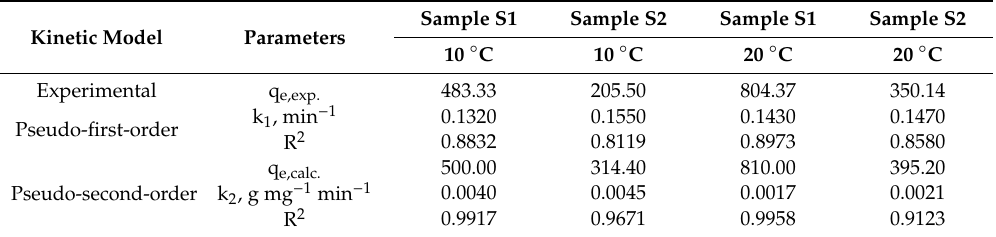
Table 4. Kinetic parameters and the correlation coefficients of Mn 2+ adsorption on Mg-Al LDH (sample S1) and Mg-Al-Ni LDH (sample S2), at 10 and 20 °C.